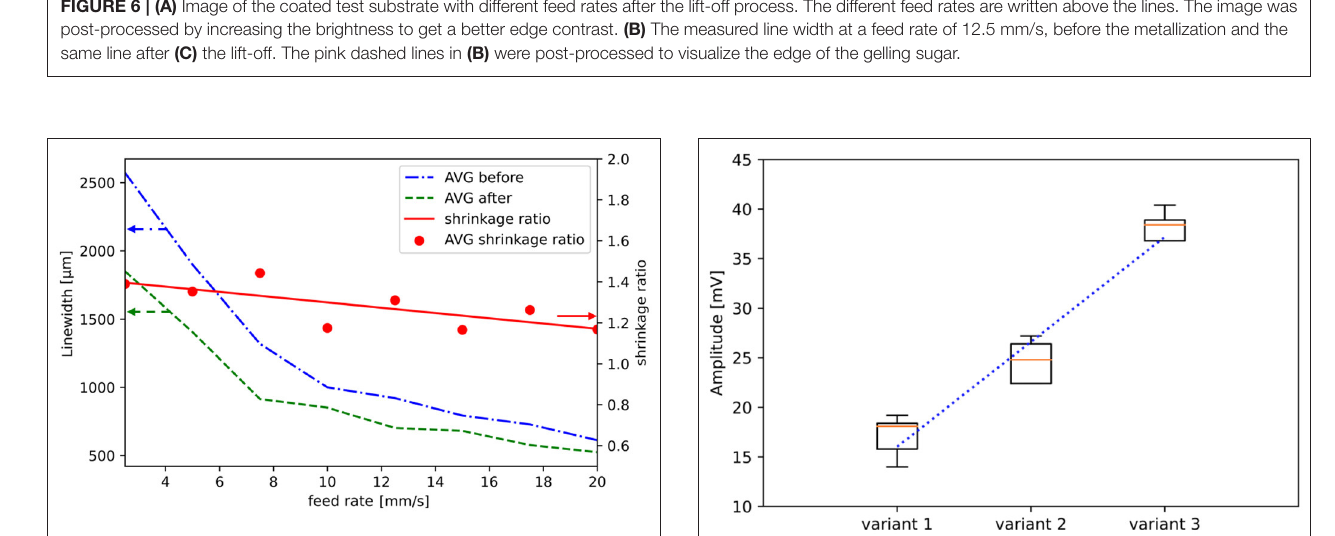
FIGURE 8 | Linear correlation (blue dot line) between the measured voltage amplitude and the different electrode variants, whose conductive surface distance differs by 1.25mm in each case. The orange lines show the median of the single measurements, which can be seen with the corresponding boxplot. Each configuration was measured 20 times. Note that the y-axis starts at an amplitude voltage of